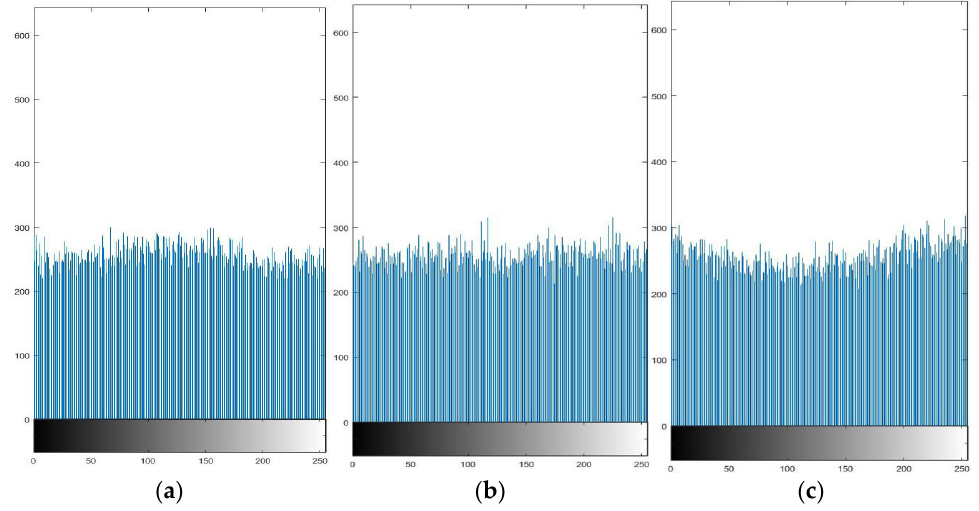
Figure 9. RGB histogram of Lena after encryption. ( a ) encrypted, Lena’s R ‐ channel pixel histogram; ( b ) encrypted, G ‐ channel pixel histogram; ( c ) encrypted, B ‐ channel pixel histogram.